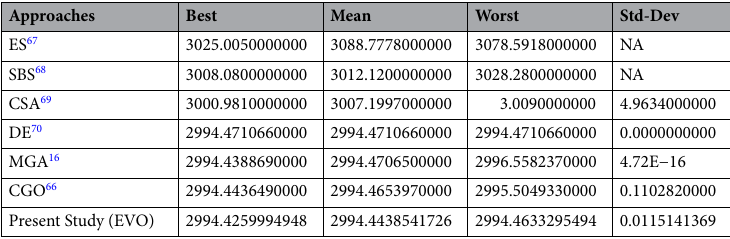
Table 9. Statistical results for the speed reducer problem considering different approaches.